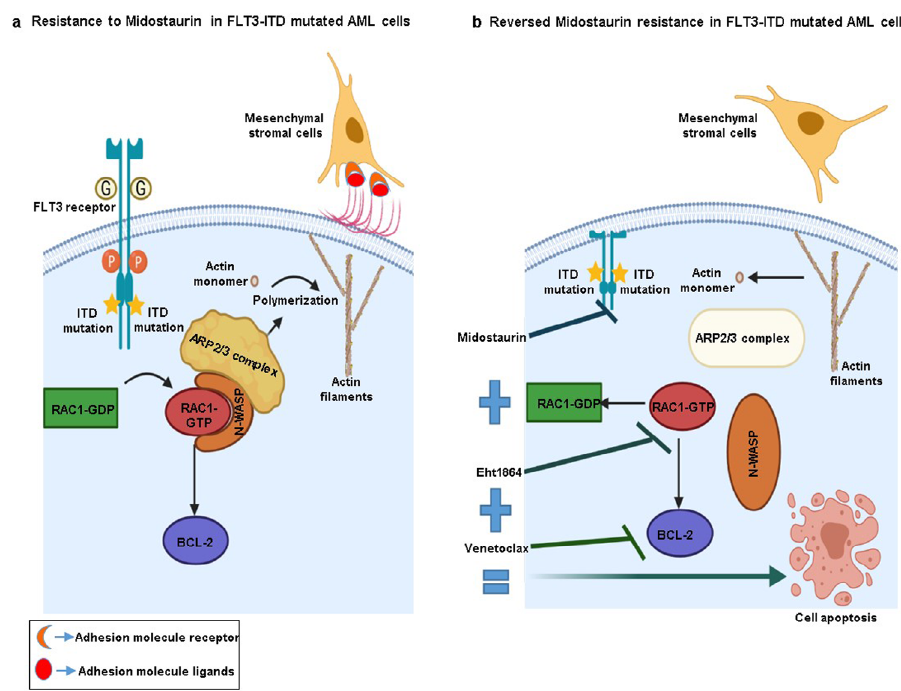
Fig. 6 Summary results fi gure. a Overactivation of actin polymerization machinery and antiapoptotic BCL-2 family in FLT3-ITD Midostaurin-resistant AML cells. b The triple combination Eht1864/Venetolax/Midostaurin by targeting Actin polymerization and BCL-2 reversed Midostaurin